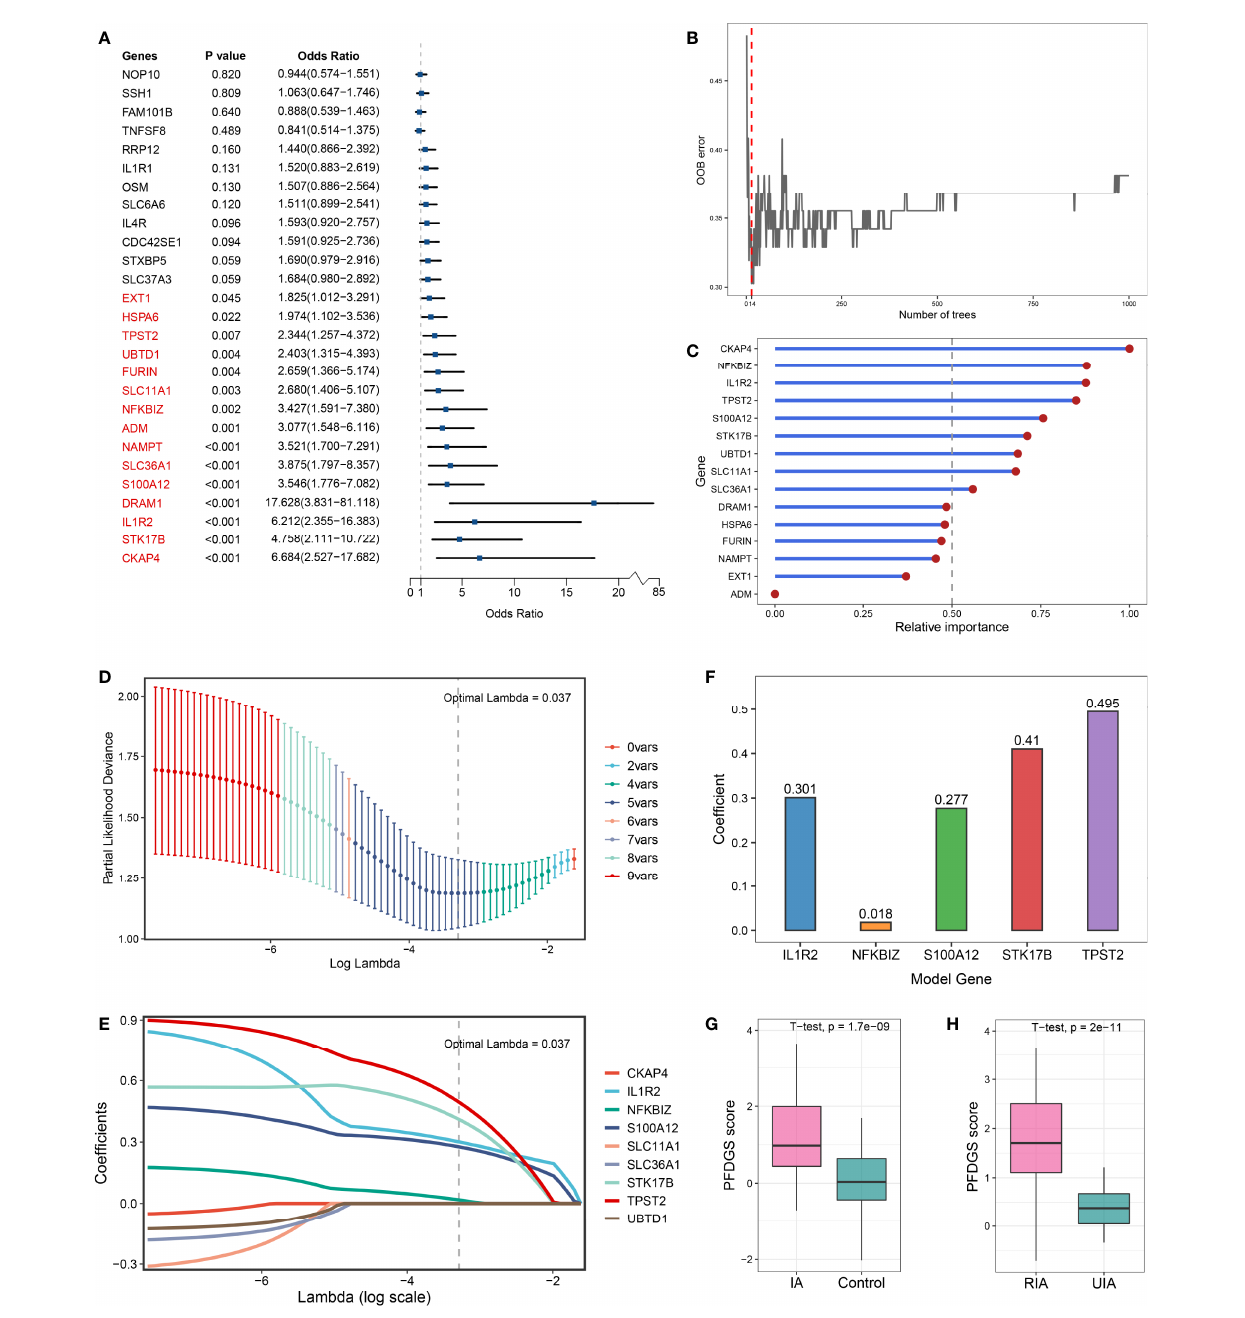
FIGURE 6 | Integrative construction of the PFDGS in blood cohort. (A) Univariate Logistic regression analysis of the 27 shared DEGs in blood and tissue. (B) Out of bag (OOB) error rate reached a minimum when the number of trees was equal to 14. (C) Relative importance of 15 initial candidate marker genes calculated in random forest. (D) The optimal lambda was determined when the partial likelihood deviance reached the minimum value. (E) LASSO coef fi cient pro fi les of the candidate genes for PFDGS construction. (F) Coef fi cients of 5 model genes in PFDGS. (G, H) Comparison of the PFDGS scores between IAs and controls (G) and between RIAs and UIAs (H)